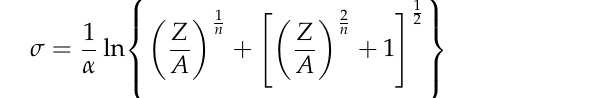
Figure 7. The relationship between ln Z and lnsinh(𝛼𝜎 𝑝 ) . With the above parameters, the constitutive equation of hot deformation of Fe-Cr-Al- La stainless steel is obtained, as shown in Equation (10).